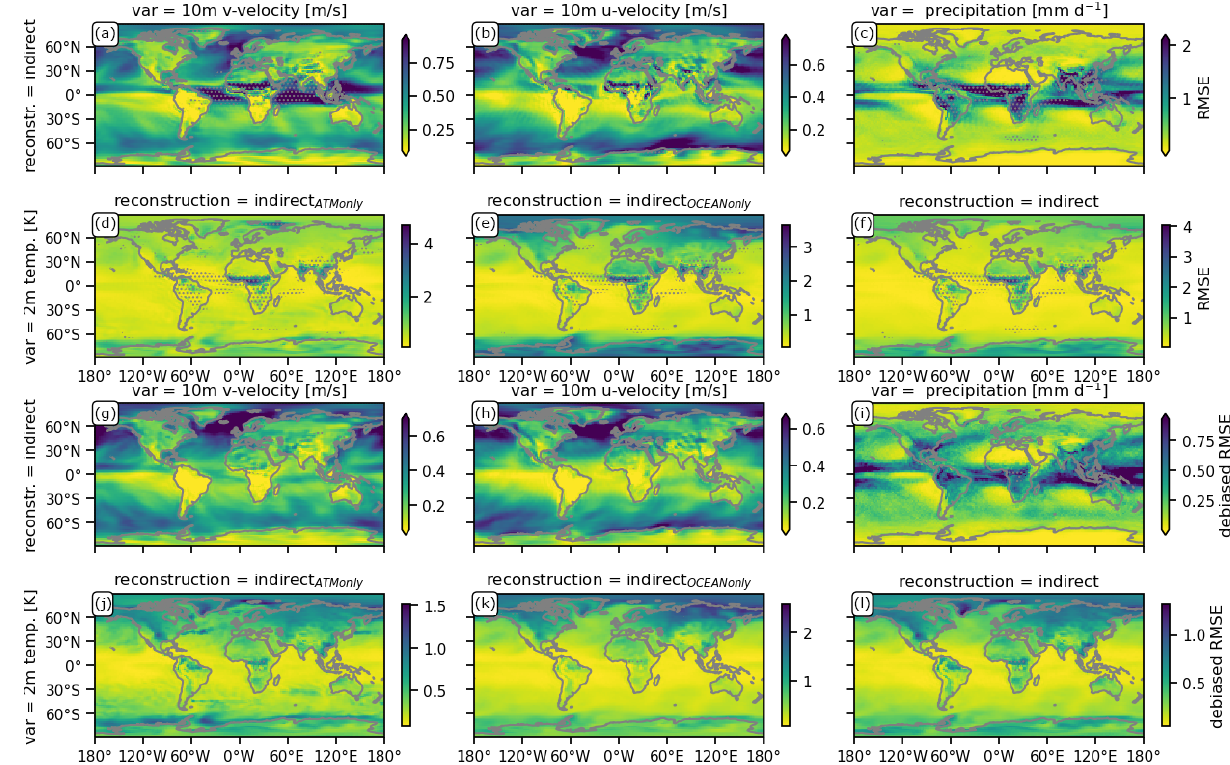
Figure B1. The same as Fig. 1 but for RMSE (a–f) and for RMSE after bias reduction (g–l) .